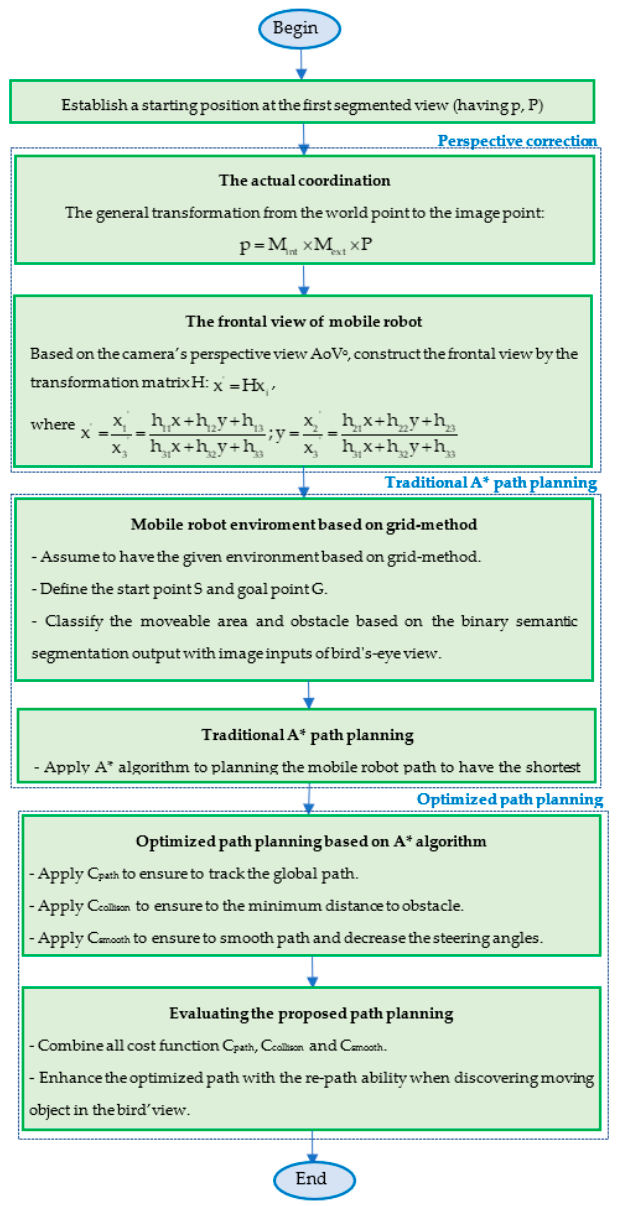
Figure 12 . The optimization trajectory work fl ow . Figure 12. The optimization trajectory